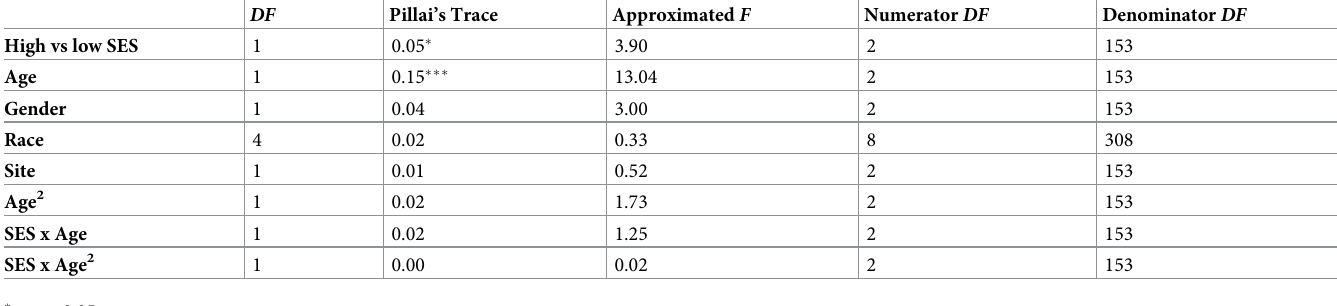
Table 8. MANCOVA of inhibition/impulsivity measures as a function of low and high SES controlling for race ( N = 185).